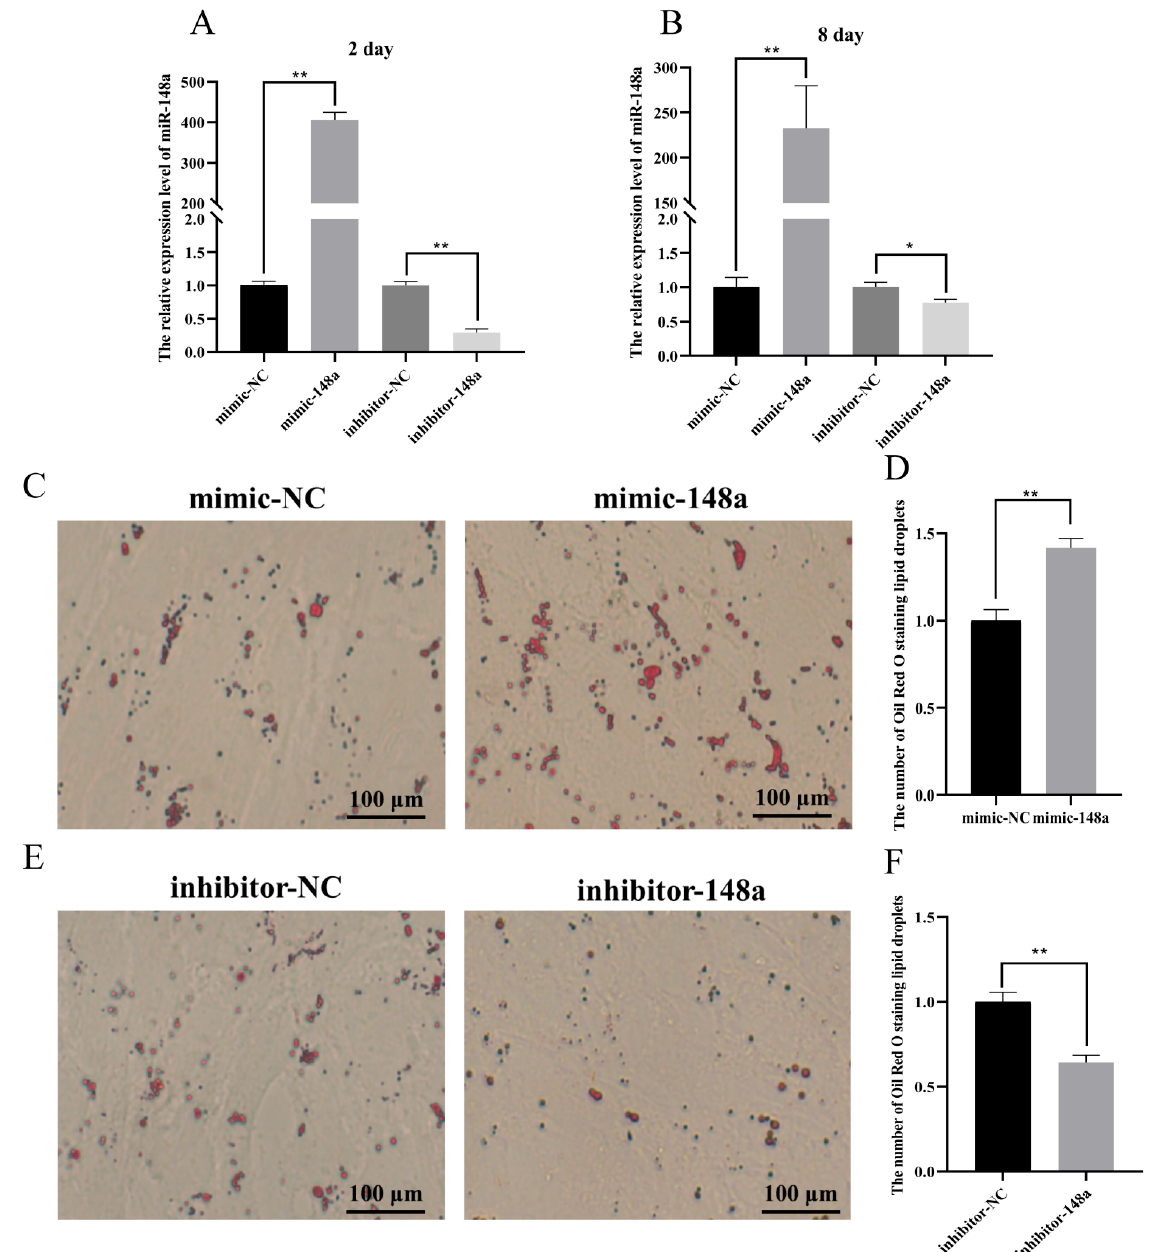
Figure 2. The miR-148a enhanced ovine preadipocyte differentiation. The miR-148a mimic, miR-148a inhibitor and negative control (NC) were transfected into preadipocytes at 50 nM. ( A , B ) The over-expression efficiency of miR-148a in adipocytes on day 2 and 8 after being transfected with the miR-148a mimic, miR-148a inhibitor and negative control (NC). ( C ) Oil Red O staining was performed in differentiated ovine preadipocytes after being transfected with miR-148a mimic and NC. ( E ) Oil Red O staining was performed in differentiated ovine preadipocytes after being transfected with miR-148a inhibitor and NC. ( D , F ) The areas of Oil Red O staining were counted using the ImageJ software. The results are depicted as the mean ± SD ( n = 3), * p < 0.05, ** p < 0.01.